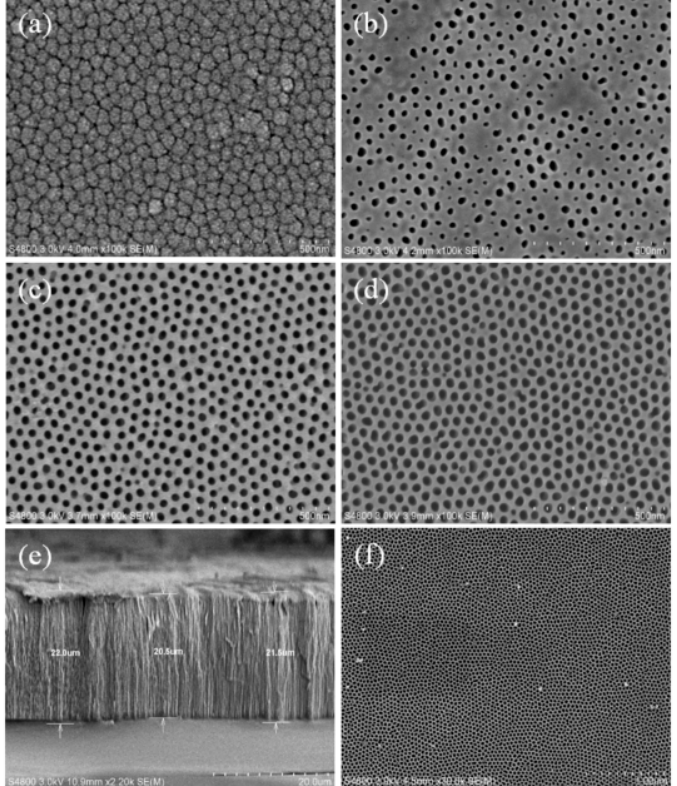
Figure 4. SEM images by dipping the AAO template for the different time: ( a ) 15 min, ( b ) 19 min, ( c ) 20 min, ( d ) 25 min. ( e ) The cross-section of the AAO template. ( f ) The AAO template of form pore size around 20 nm.